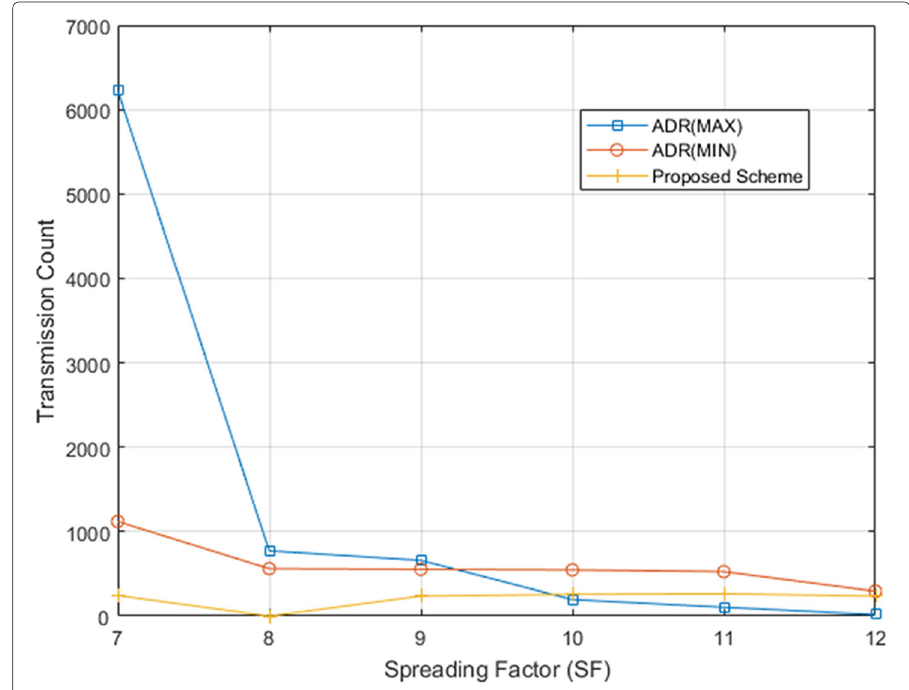
Fig. 8 SF distribution of LoRa terminal